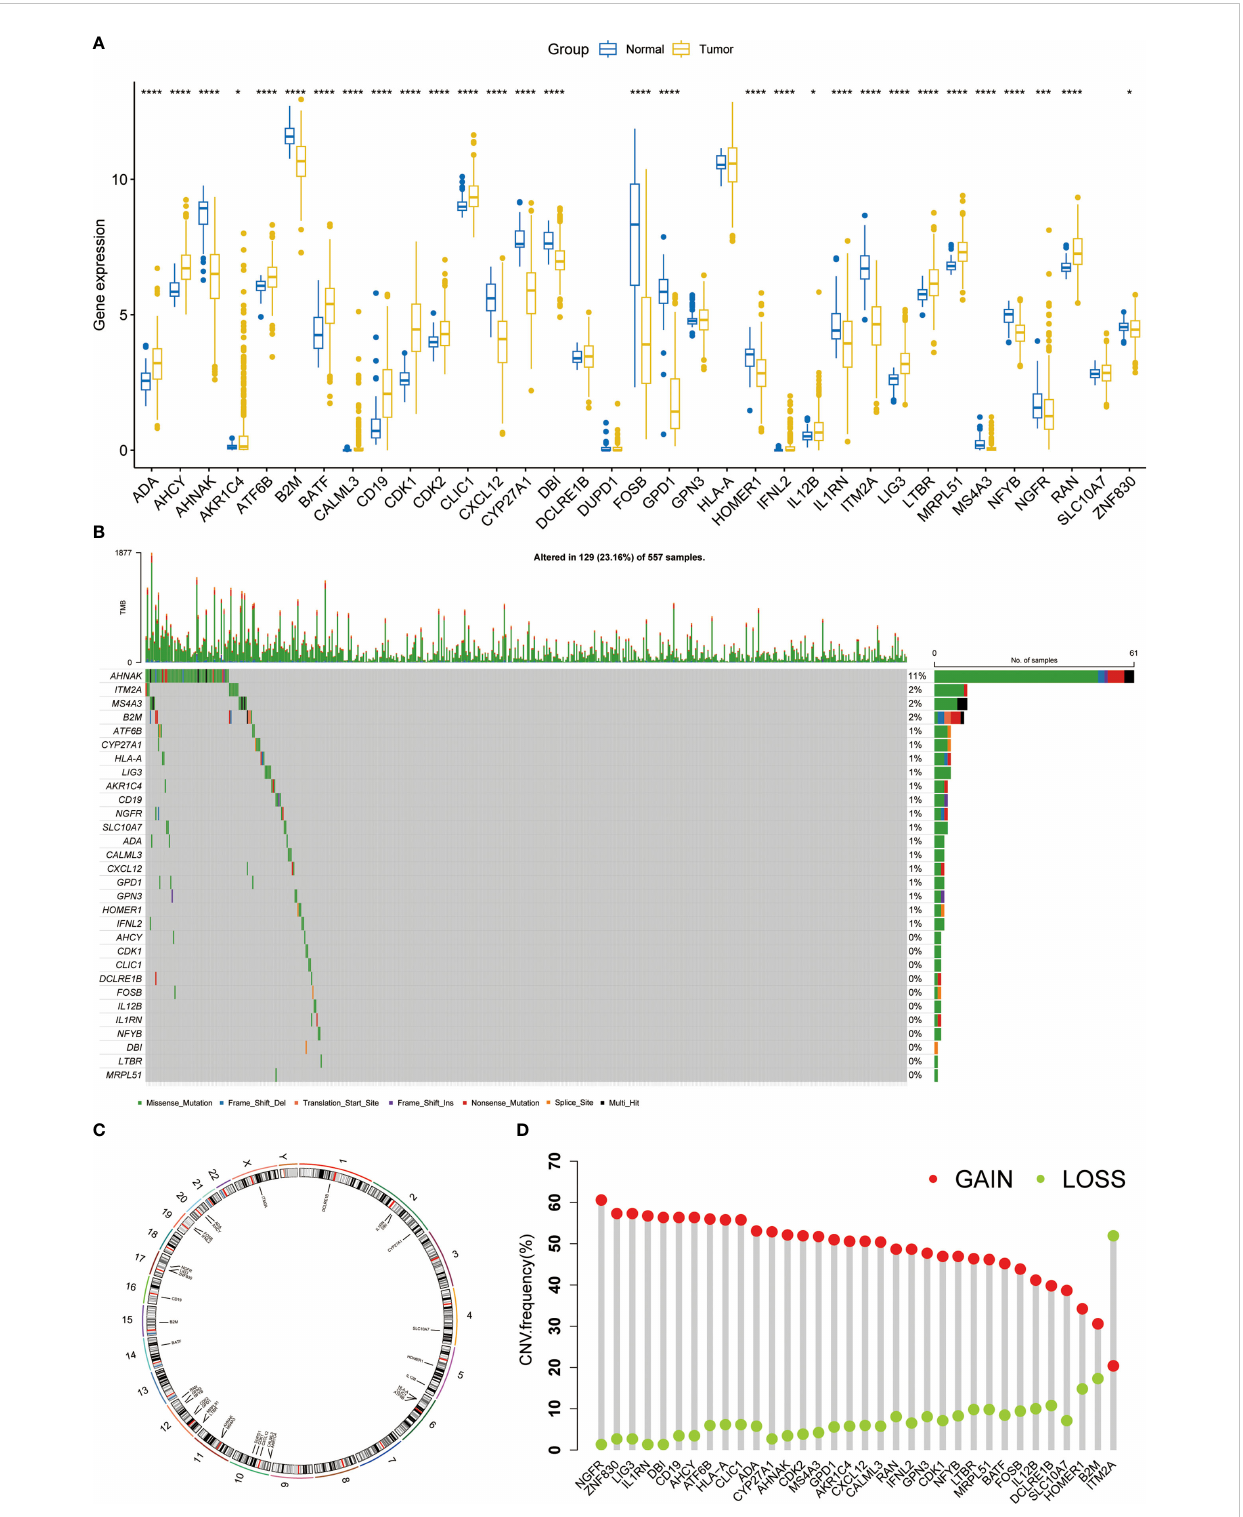
FIGURE 1 The expression and genomic features of T cell proliferation regulators in LUAD. (A) The differential expression of T cell proliferation regulators between tumor and normal samples. (B) Mutation landscape of T cell proliferation regulators in TCGA. (C) Chromosome position and alteration of T cell proliferation regulators. (D) The CNV mutation frequency of 35 T cell proliferation regulators. *p < 0.05, ***p < 0.001, ****p <